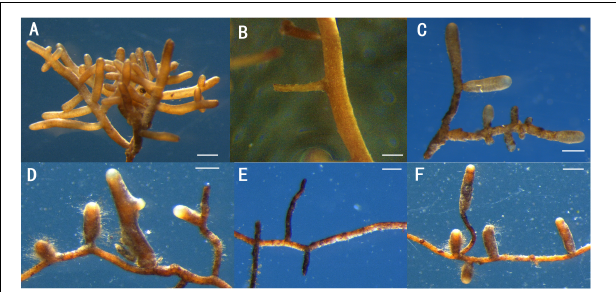
FIGURE 1 | Two ectomycorrhizae and roots of Quercus aliena without Tuber species partner, Scale bar = 1 mm. (A,D) Ectomycorrhizae of Q. aliena seedlings with Tuber indicum ; (B,E) root of Q. aliena without Tuber partner; (C,F) Ectomycorrhizae of Q. aliena seedling with Tuber melanosporum .